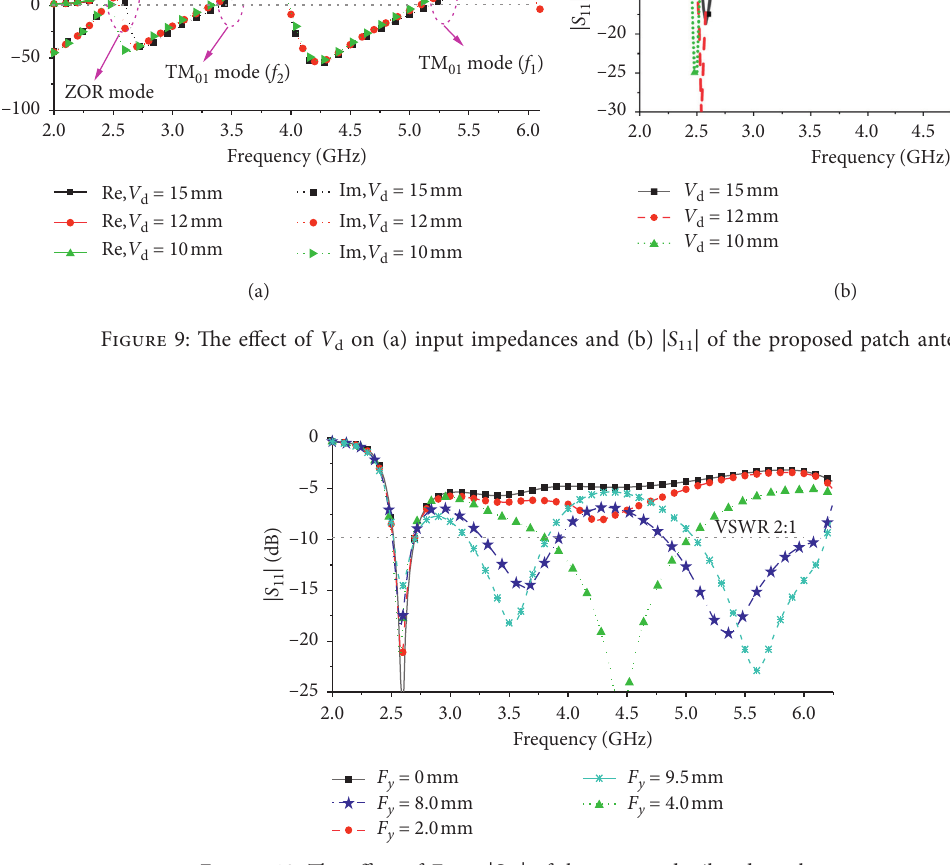
Figure 10: The effect of F y on | S 11 | of the proposed triband patch